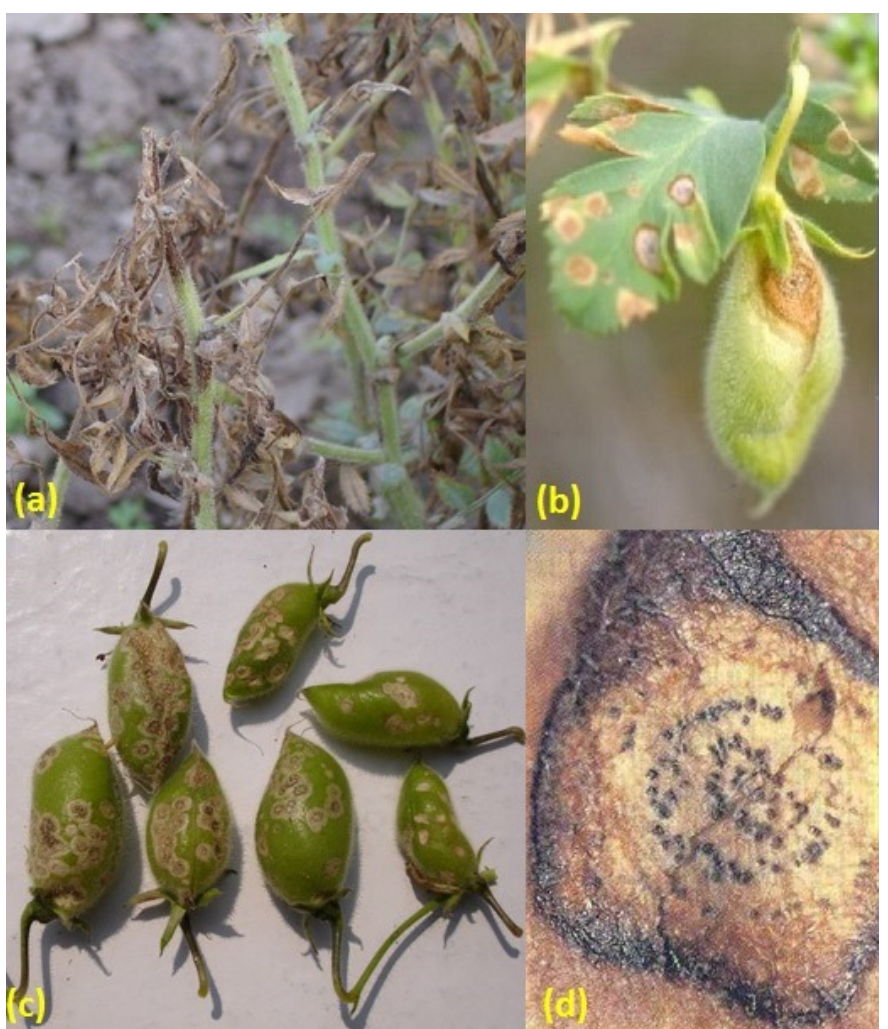
Figure 1. Ascochyta blight symptoms on chickpea plant ( a ) Severe AB infection on all aerial parts ( b ) Lesions on leaf and pods ( c ) Lesions on green pods ( d ) Pycnidial bodies arranged in concentric